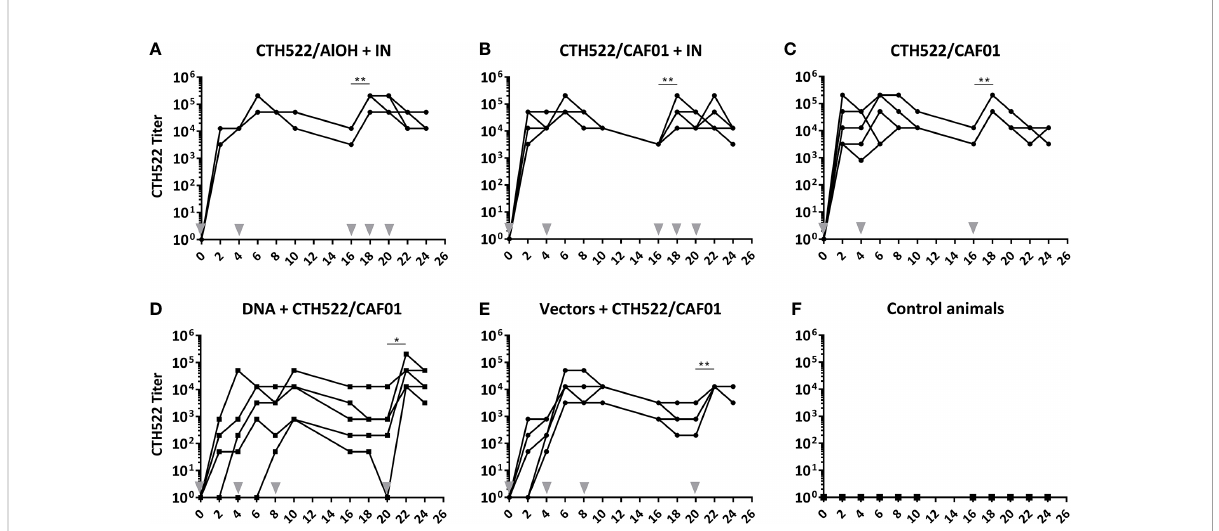
FIGURE 2 (A – F) Serum CTH522 IgG antibody responses. Cynomolgus macaques were immunized following different prime-boost regimes ( n = 5 per group) and serum was collected every second week. The speci fi c CTH522 IgG antibodies in serum were evaluated by ELISA and expressed here as titer on a log10 scale. Grey arrowheads indicate vaccinations. Each line represents one animal. Statistical signi fi cance is indicated with asterisks *p < 0.05 and **p <